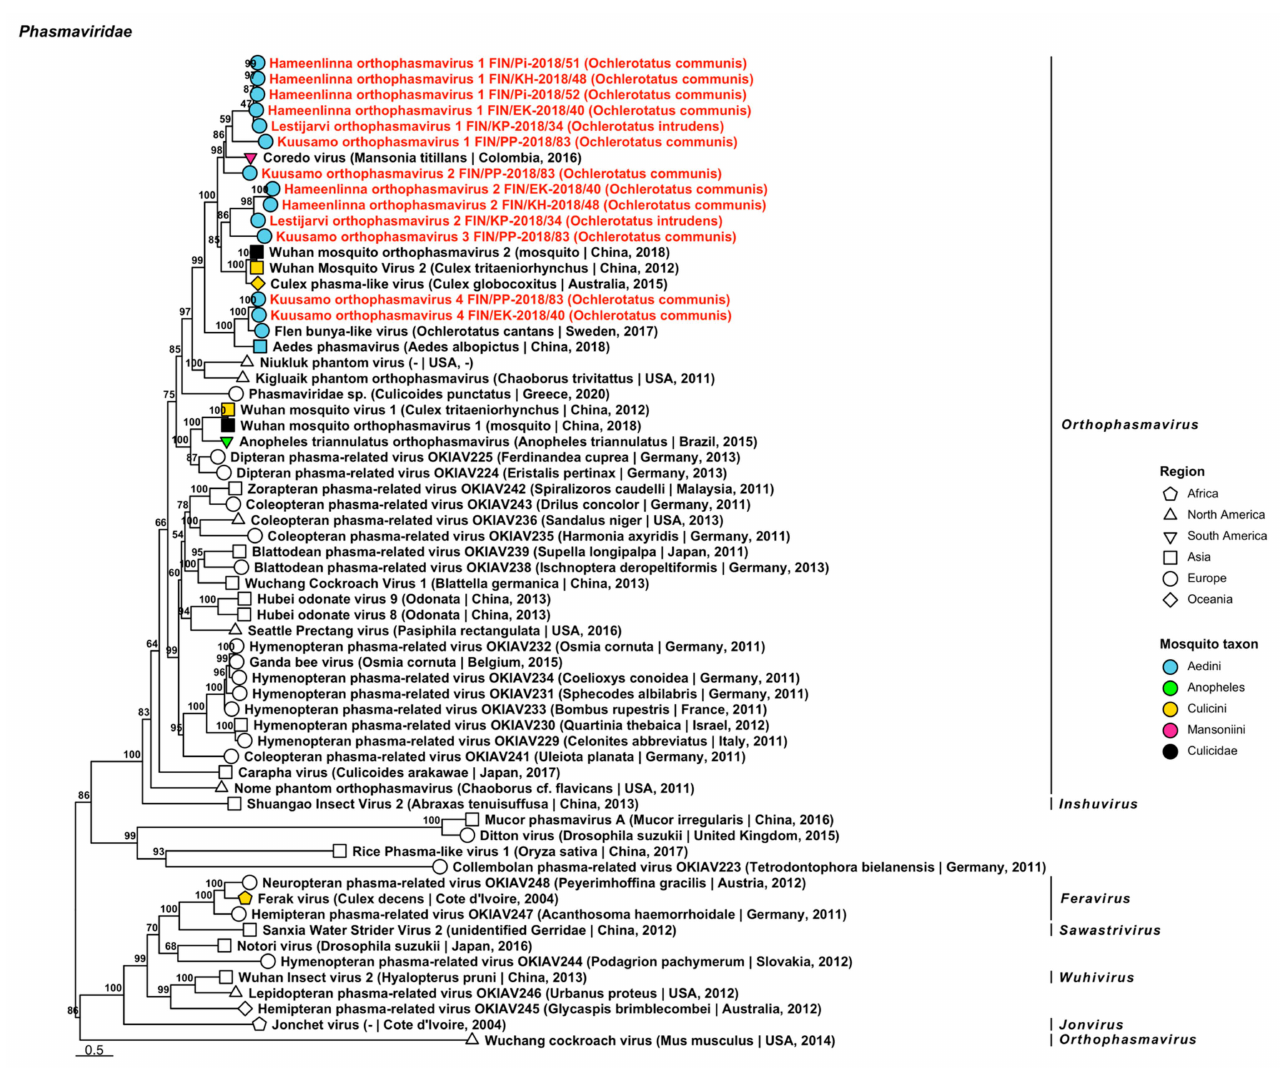
Figure 11. Maximum likelihood tree of Phasmaviridae . Tentative novel viruses are displayed in red and the mosquito species from which they were derived are in parentheses. Sequences from GenBank are black and display the following information after the virus or species name: “(sampled organism(s)|collection country, collection year)”. Tip colours represent the tribe (Culicinae) or genus (Anophelinae) of mosquito from which viruses were obtained. Tip shape represents the continent or region from which the specimens were collected. Trees were constructed from amino acid sequences of virus polymerases >1000 nt, aligned with MAFFT and computed with IQ-TREE2 using ModelFinder and 1000